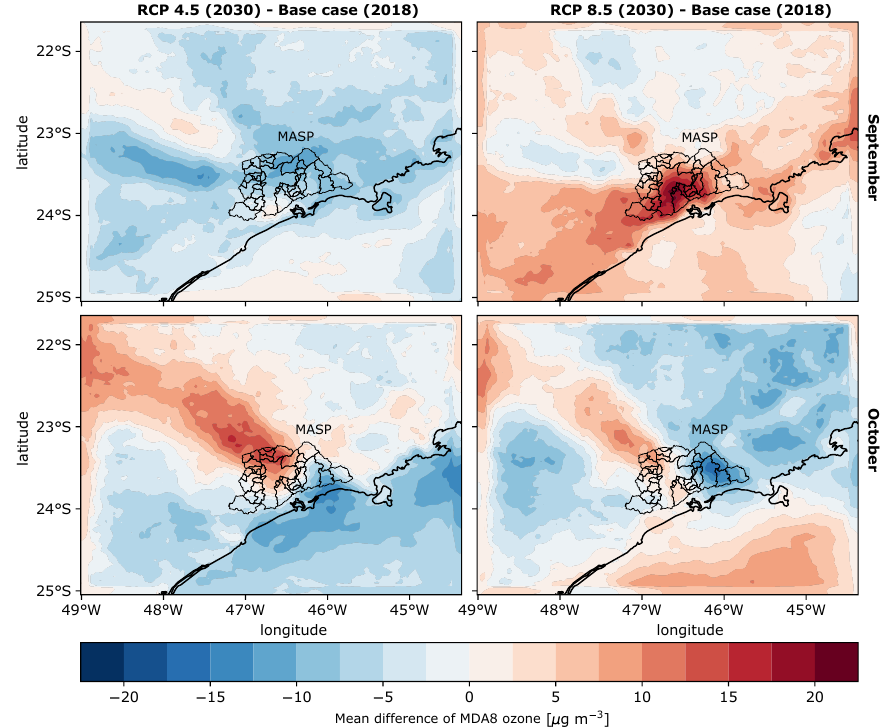
Figure 8. Variability by monthly mean for MDA8 O 3 between RCP scenarios and the base case scenario (2018), applied for the second modeling domain area. The MASP is located at the center of the map (Reprinted/adapted with permission from Ref. [37]. 2021, Universidade de São